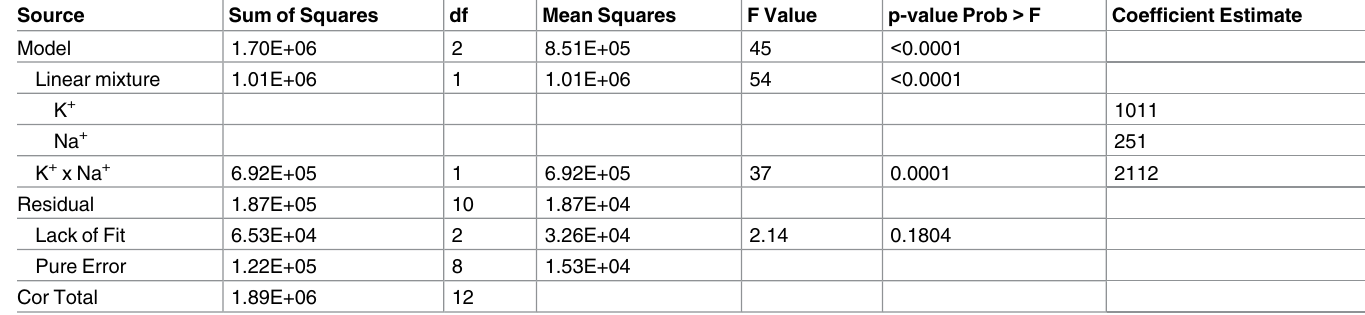
Table 7. ANOVA of the effect of K + and Na + on fresh weight growth of citrus nonembryogenic cells. The coefficients for K + and Na + under the linear mixture are estimates of the response at each vertex, not estimates of the effects of these two ions. The K + x Na + term is not an interactionterm, though it looks like one, but a quadratic blendingterm uniqueto mixture models. This term is used to determine if the mixture components exhibit nonlinearblending and if that blendingis synergistic or